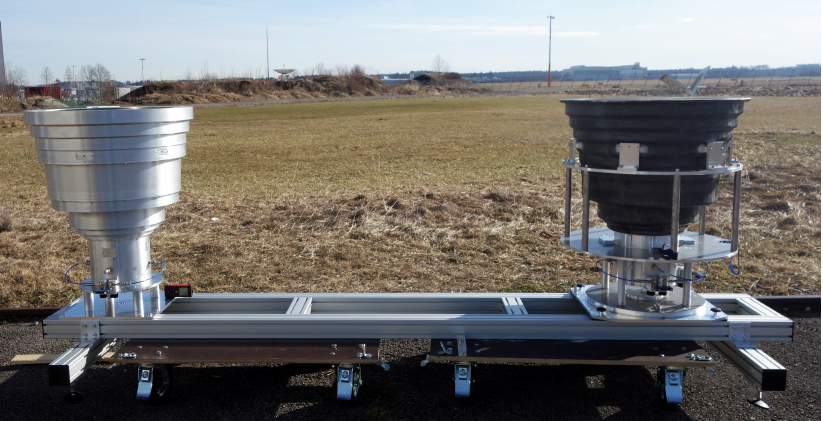
Figure 7. Outdoors coupling measurement setup. For the measurement one aluminum ( left ) and one CFK VEGA antenna ( right ) with equal radiation characteristics were used. Not shown in the picture is the vector network analyzer (VNA) used to measure all coupling parameters at different distances between the